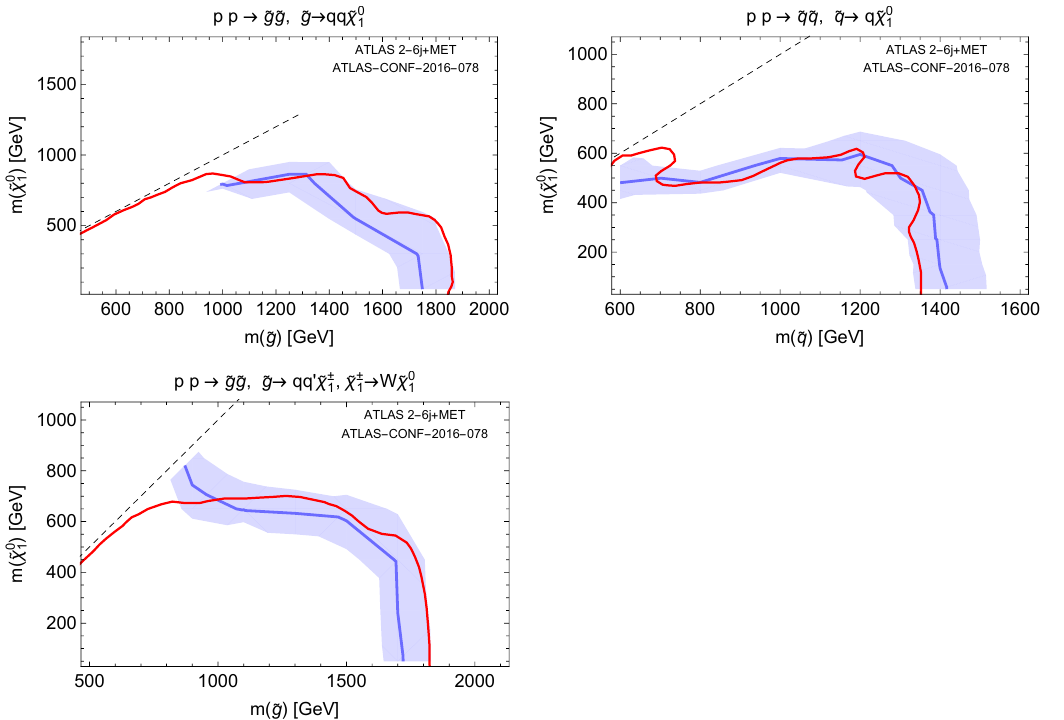
Figure 12 . Limits on supersymmetric simpli(cid:12)ed models from our recasted search of [29] (blue lines) with 50% error on the number of events in the signal regions (blue shaded regions), compared to the experimental results (red